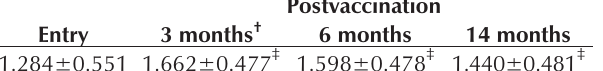
Details of the cohort (n=50) Mean absorbance value ± SD of varicella antibodies (ELISA)*